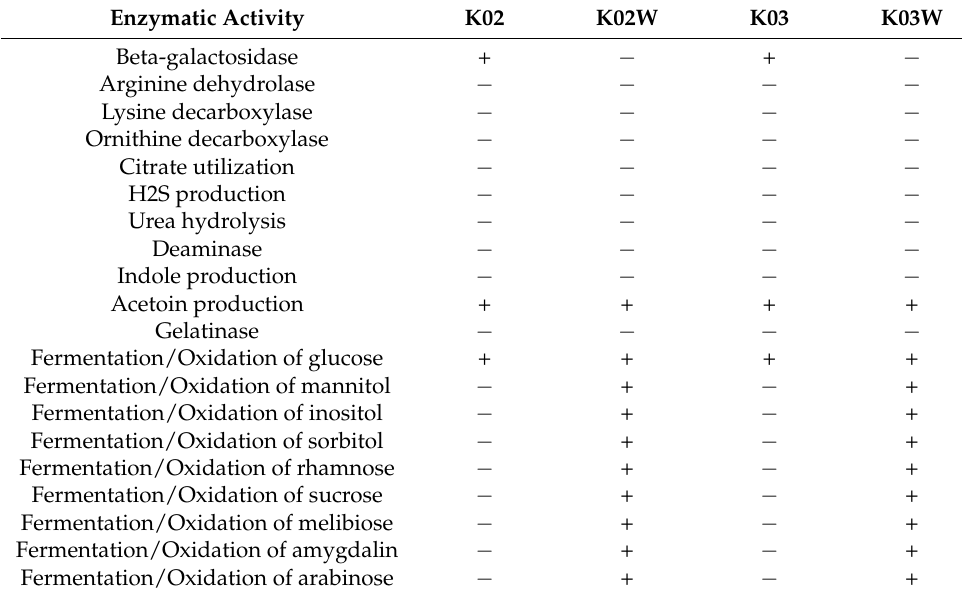
Table 2. Enzymatic activity of kefir beverages and kefir